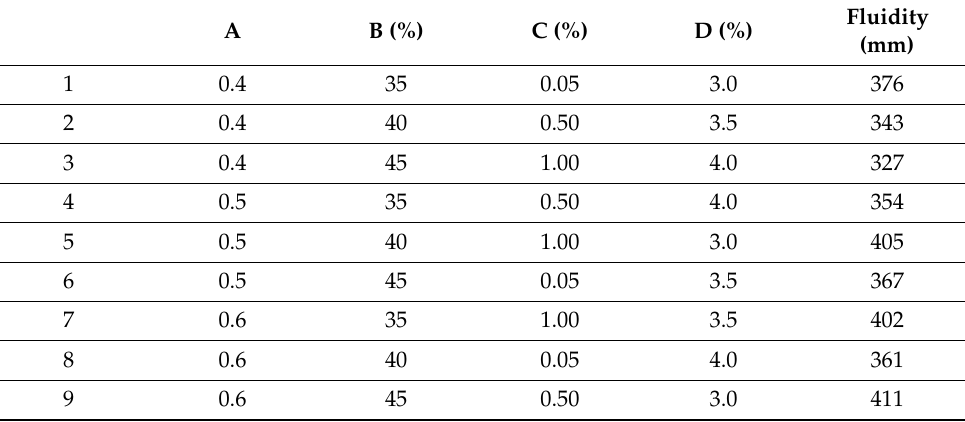
Table 6. Results of orthogonal-test data.